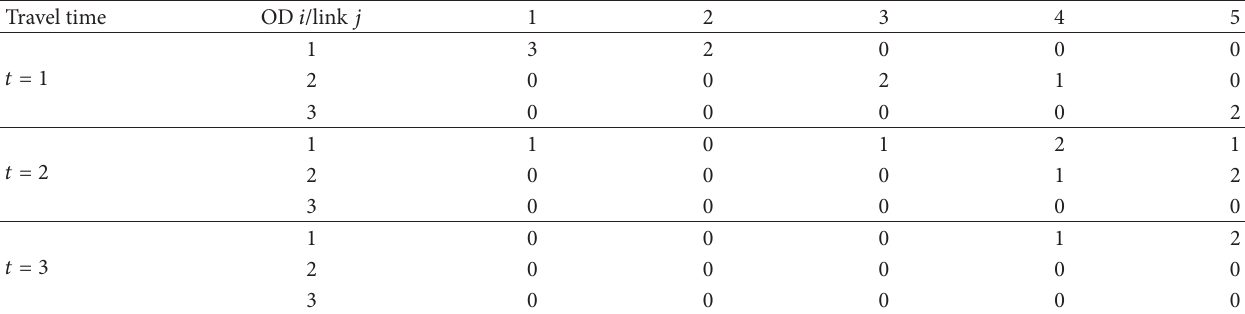
Table 7: Summary of ̂𝑧 𝑘,𝑘+𝑡 𝑖,𝑗 in the hypothetical